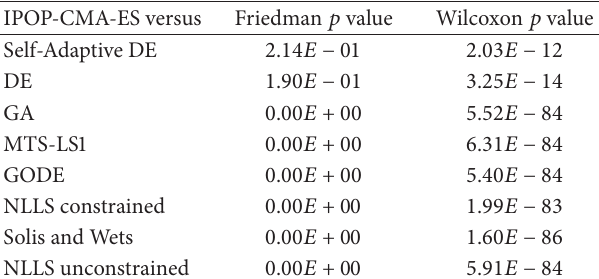
Table 9: Raw 𝑝 values (Self-Adaptive DE is the control algorithm) for the 8-term Fourier series.